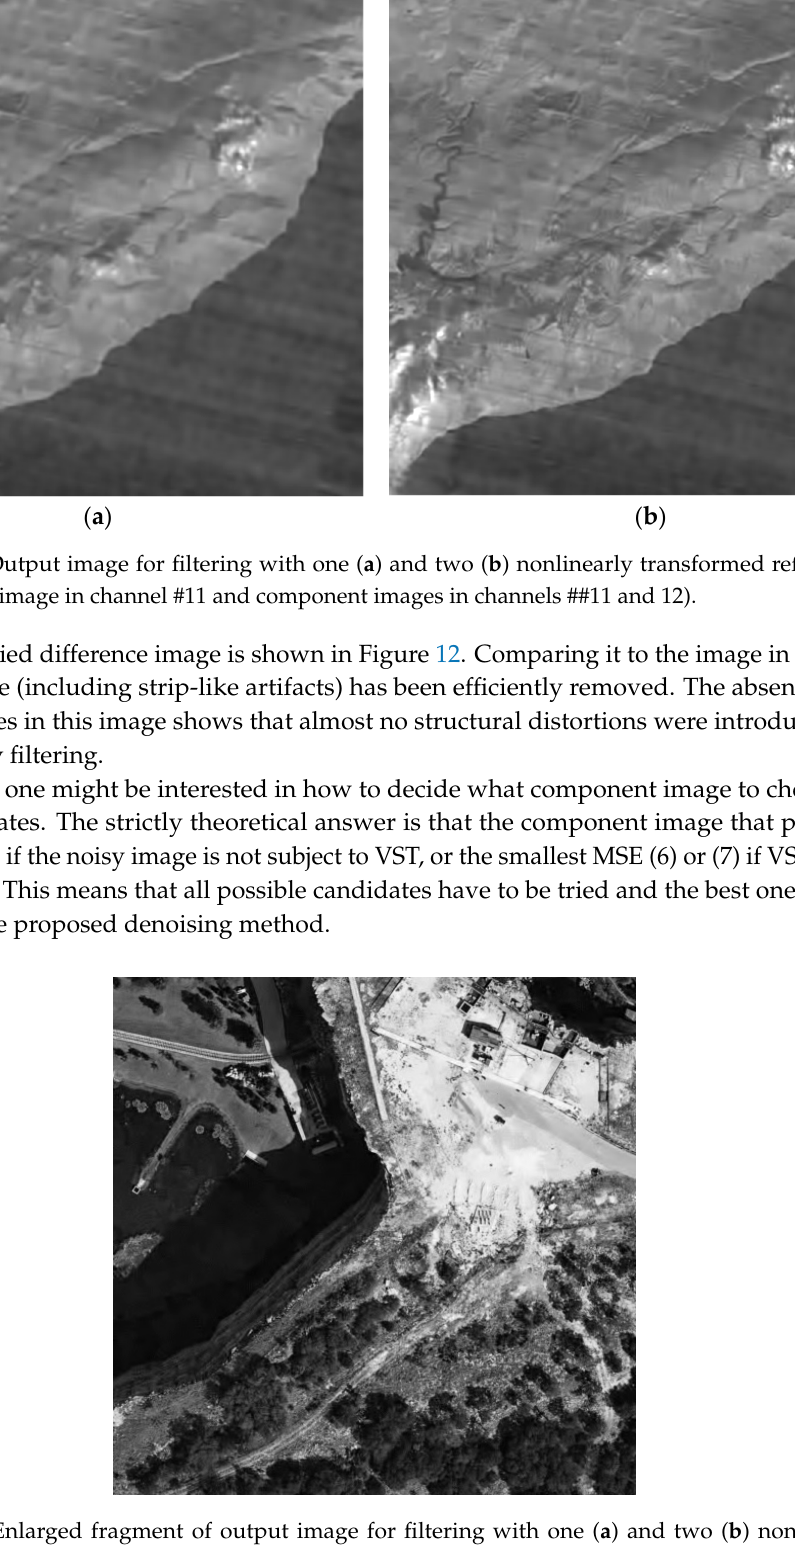
Figure 9. Filtered noisy image by 3D-DCT ( β = 3.0) with reference transformed by second order polynomial (PSNR out = 35.34 dB; PHVSM out = 39.24 dB). The denoising efficiency can be additionally improved if one uses two reference images and/or a BM3D filter instead of a DCT-based filter in the denoising with reference. 3.2. Application to Real Life Images Let us see how good the filtering result is if denoising with reference is applied to a real-life image. The output for the 2D DCT-based filter has been already shown in Figure 2 and that image was partly smeared. The output of the proposed denoising technique with one nonlinearly transformed reference (second order polynomial was used) from channel #11 is shown in Figure 10a. The output for the case of using two nonlinearly transformed references numbers 11 and 12 (again, the second order polynomial was applied) is demonstrated in Figure 10b. Both images are considerably “sharper” than the image in Figure 2 and more details are visible. Comparing the images in Figure 10 and the enlarged fragments in Figure 11, it is possible to state that the use of two reference images produces better visual quality of the processed image.